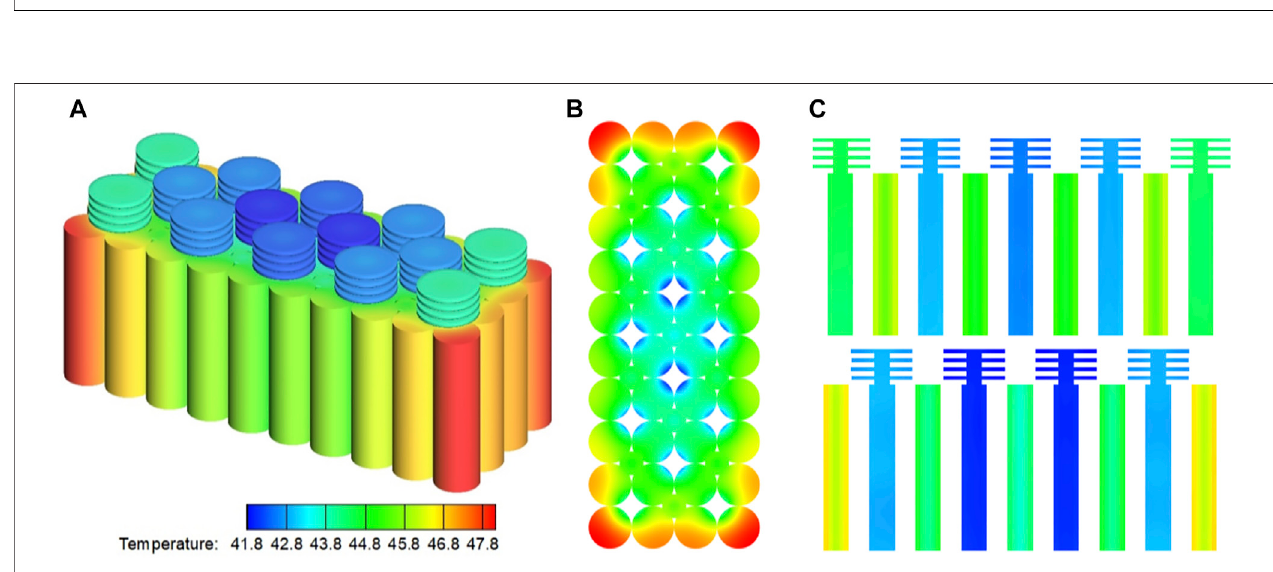
FIGURE6| Contoursoftemperatureattheenddischargeprocess: (A) plotwithallthepartsincluded; (B) topviewwithheatpipesand fi nsnotincluded; (C) section planes. Reproduced with permission (Peng et al., 2022). Copyright 2018, Elsevier.